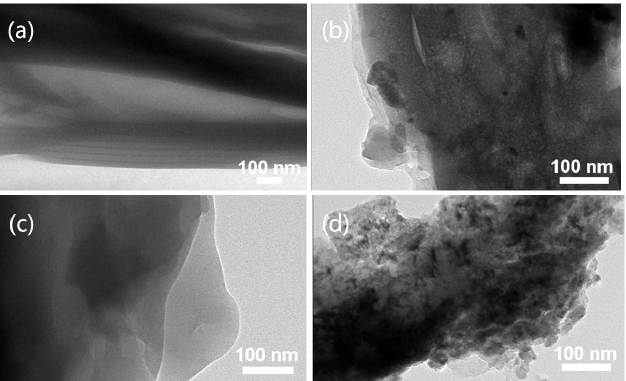
Figure 4. TEM images of porous composite fiber membranes prepared by different modification methods: ( a ) CA; ( b ) 3 wt% HCl-MMT/CA; ( c ) 4 wt% SDS-MMT/CA; ( d ) 5 wt% CTS-MMT/CA.